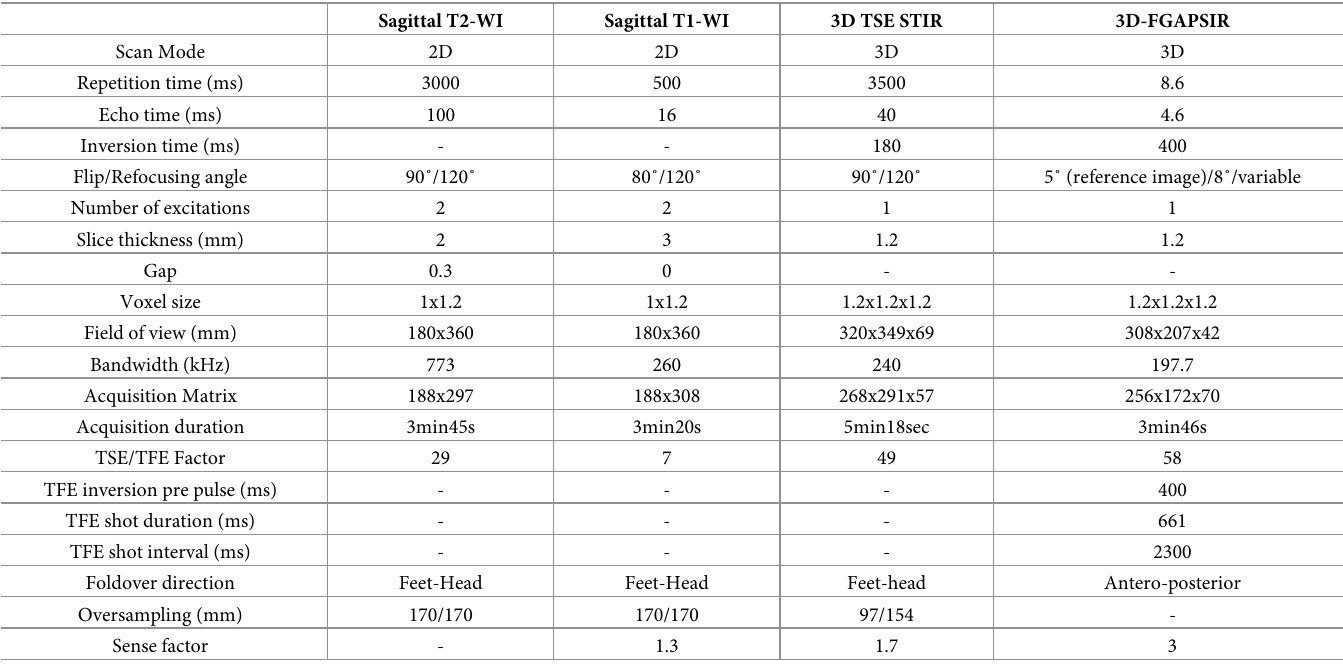
Table 1. Detailed MRI acquisition